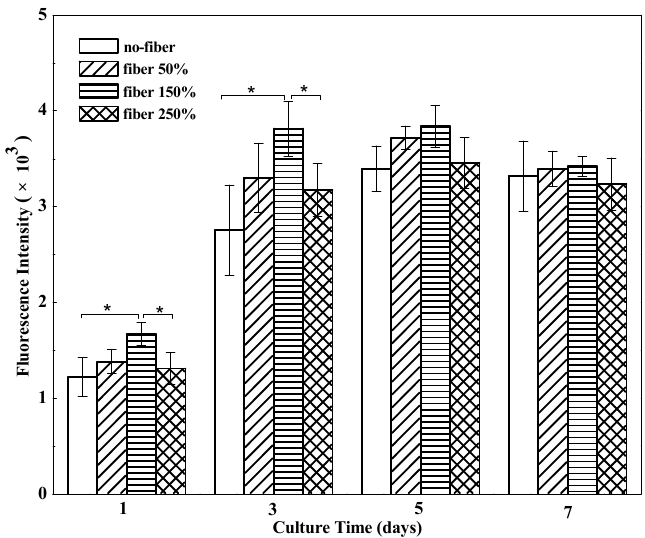
Figure 5. Proliferation of EA. hy926 cells cultured on BSF scaffolds with different proportions of ASF micro/nano fibers at days 1, 3, 5, 7. Error bars represent mean standard deviation with n = 3 (* p < 0.05).